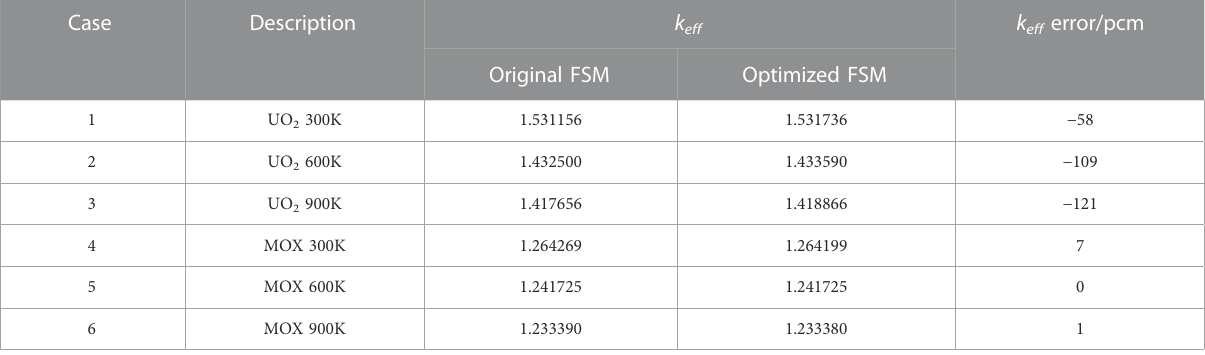
TABLE 13 Calculation results for UO 2 and MOX problems with the optimized FSM.